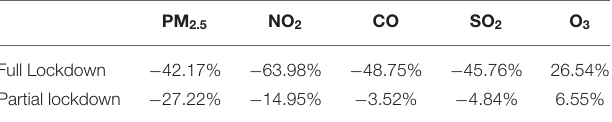
TABLE 5 | The effects of two levels of restriction on five pollutants concentrations. PM